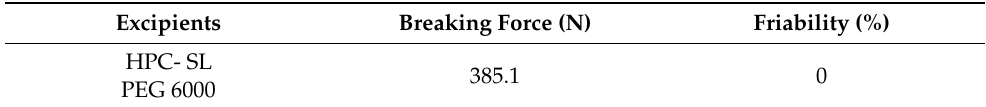
Table 3. The effect of excipients on the mechanical properties of blank (without drug) tablets produced with the FDM/HME technique